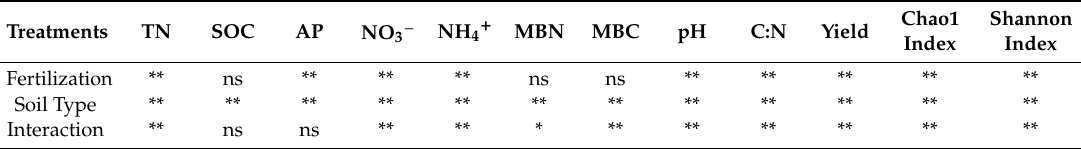
Table 3. E ff ect of fertilization, soil type, and their interaction on soil biochemical traits, maize yield, and bacterial alpha diversity